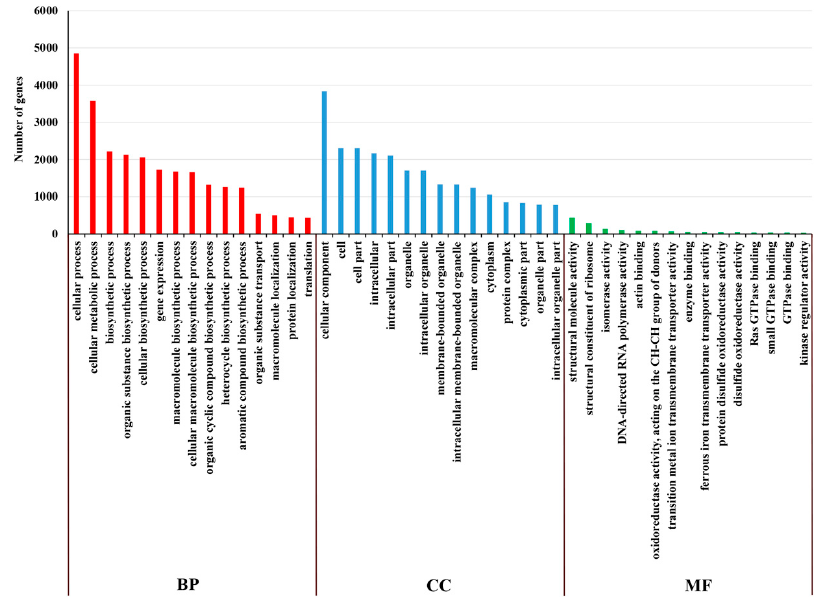
Figure 11. GO analysis of lncRNA in the cultivar “Huoche” under heat stress. The histogram of GO enrichment analysis of the targeted mRNA of DE lncRNAs. The ordinate is the enriched GO term, and the abscissa is the number of differentially expressed genes in this term. Different colors are used to distinguish biological processes, cellular components and molecular functions.